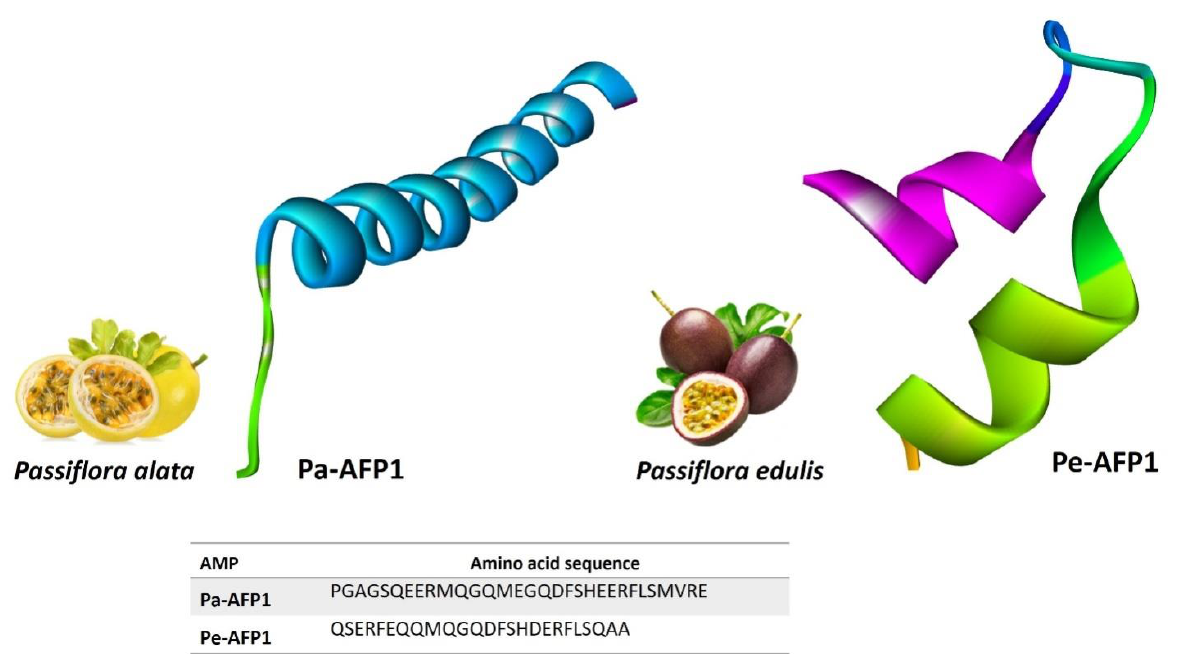
Figure 2. Selected 2S albumin proteins that have potential antimicrobial activities for food preservation: Pa-AFP1 (predicted in this study) and Pe-AFP1 (predicted in this study). Predicted structures are modeled via homology modeling using the Swiss model (https://swissmodel.expasy.org accessed on 30 July 2022).